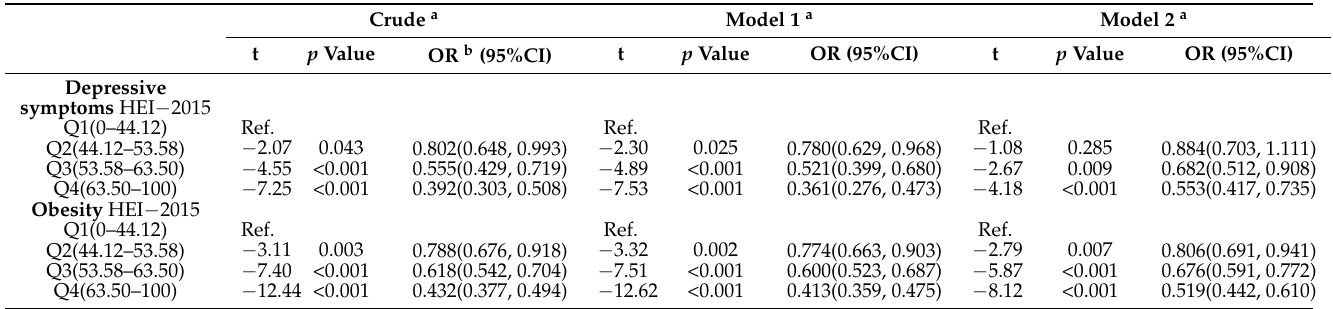
Table 3. Weighted odds ratios (ORs) with 95 percent confidence intervals (CIs) for the HEI-2015 and depressive symptoms and obesity, respectively. Crude a Model 1 a Model 2